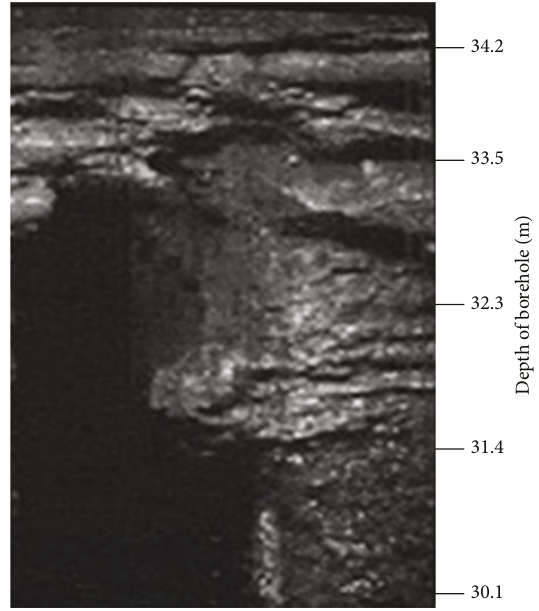
Figure 9: Development conditions of caving zone top.